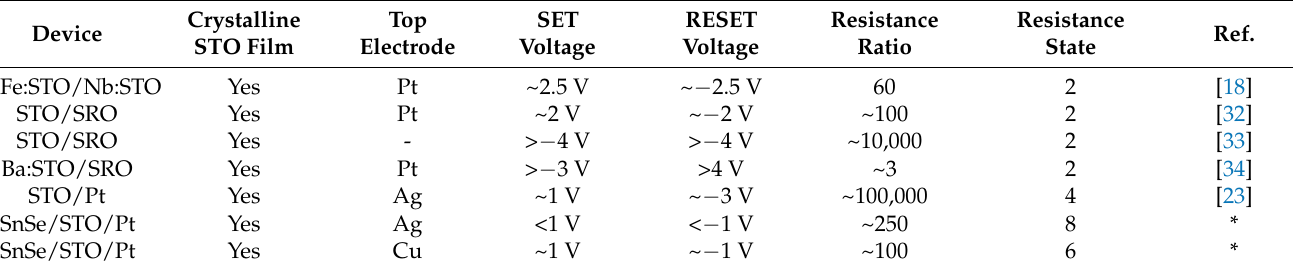
Table 1. A comparison of the devices with the polycrystalline/crystalline STO